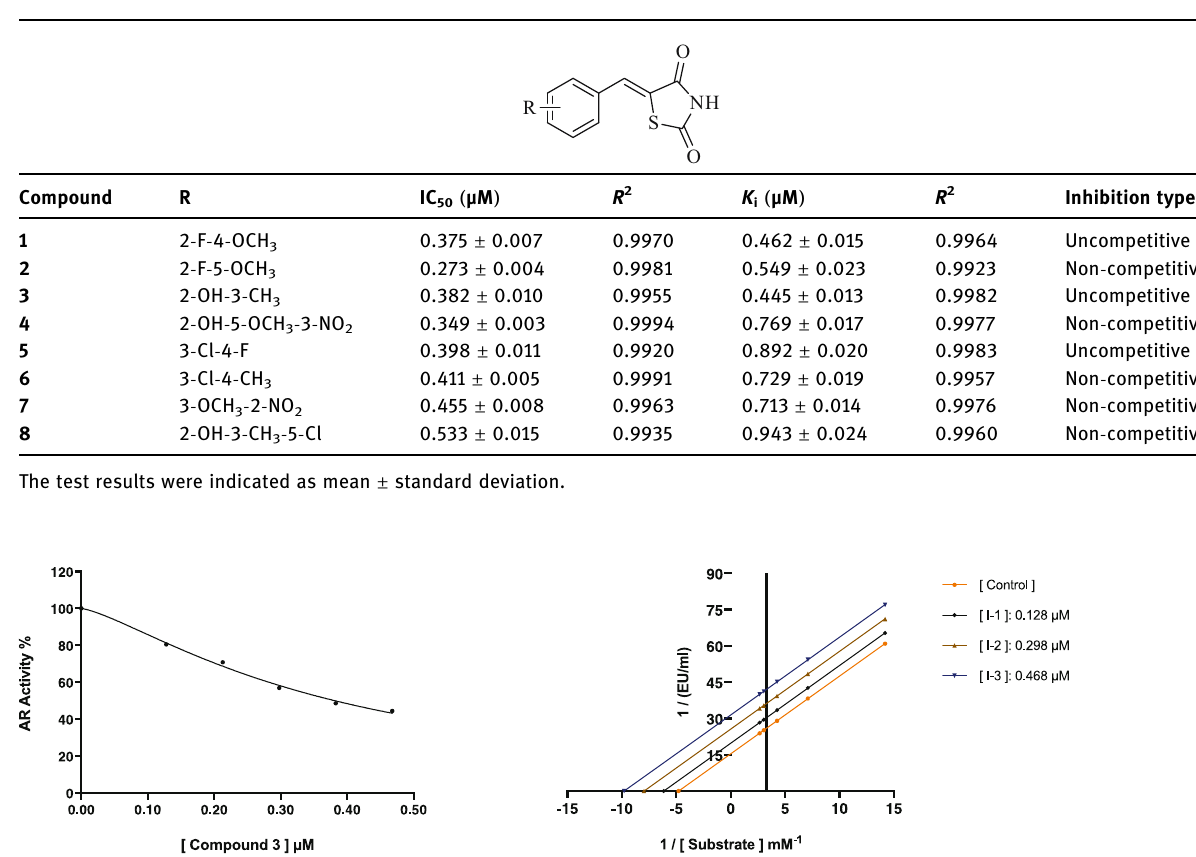
Table 1: AR inhibition data of compounds 1 – 8